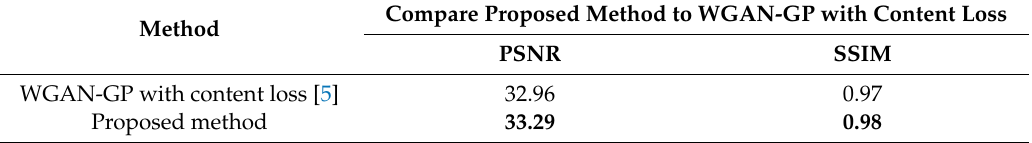
Table 3. PSNR and SSIM on GOPRO Large